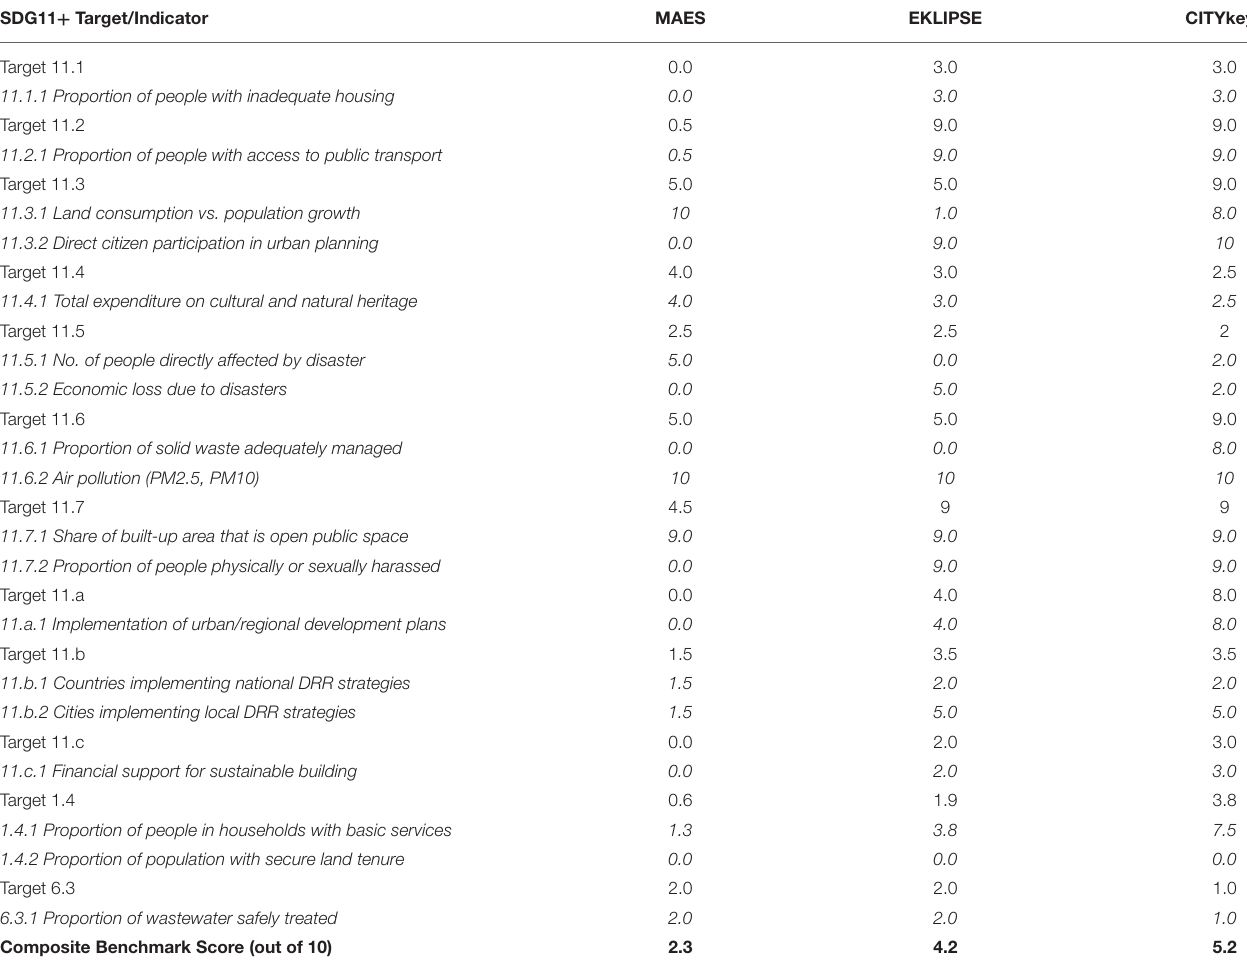
TABLE 2 | Summary of MAES, EKLIPSE and CITYkeys assessment framework quantitative benchmarking against SDG11 + targets and indicators. SDG11 +